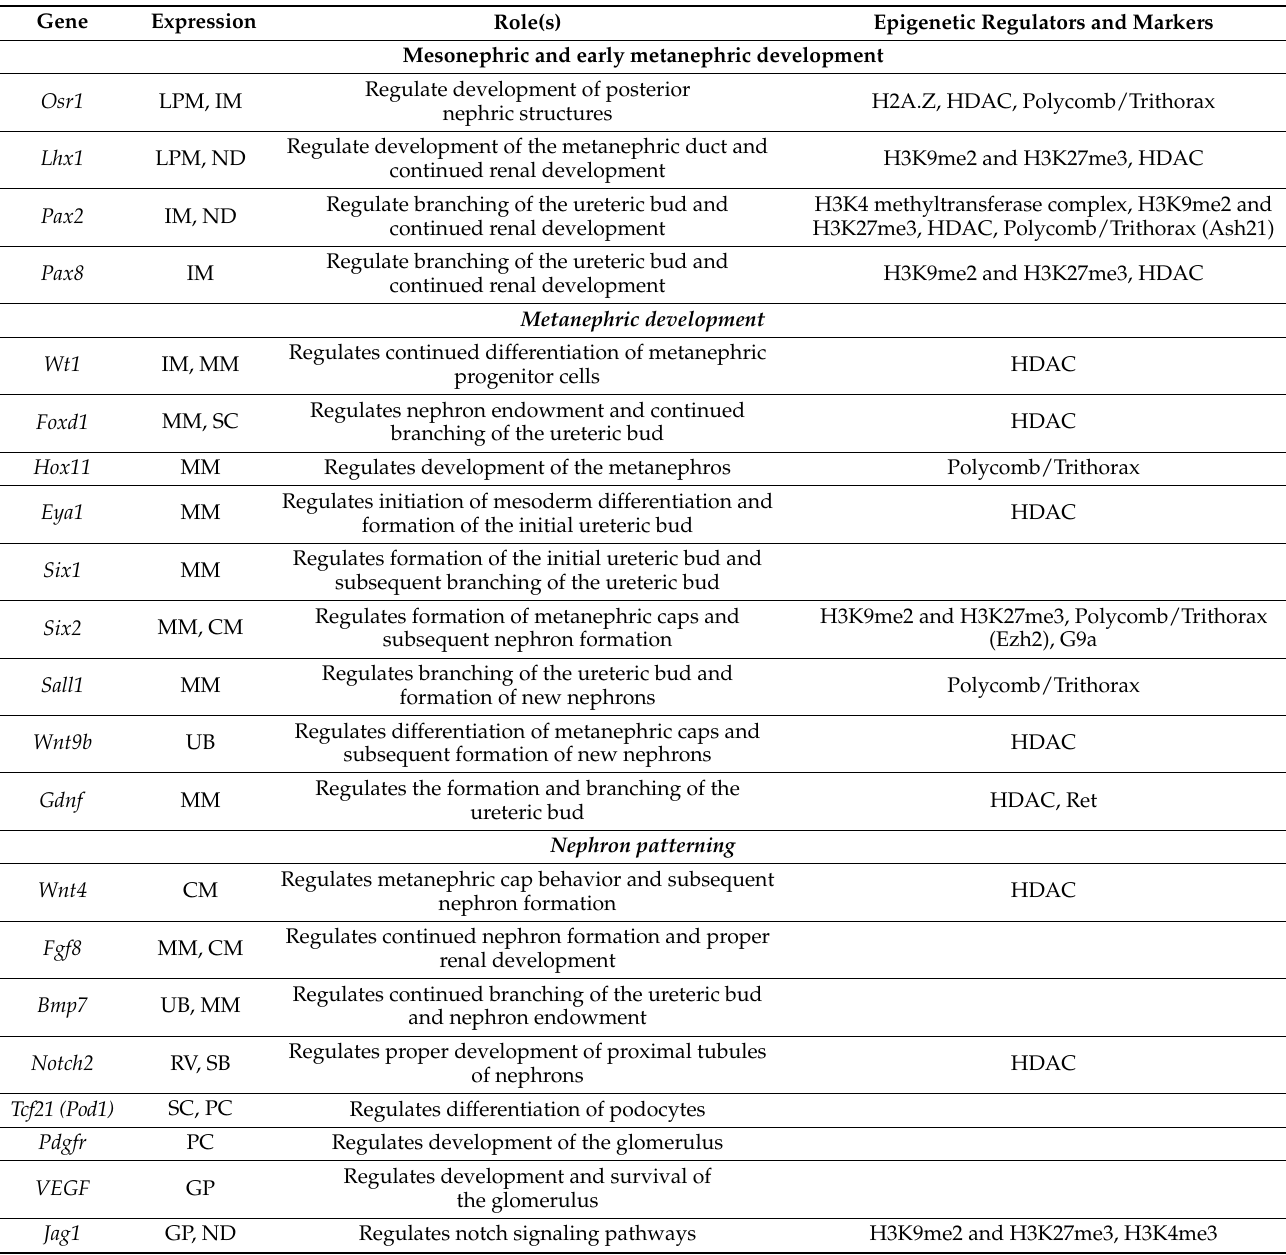
Table 1. Important genetic factors regulating proper kidney development and their associated epigenetic regulators and markers.